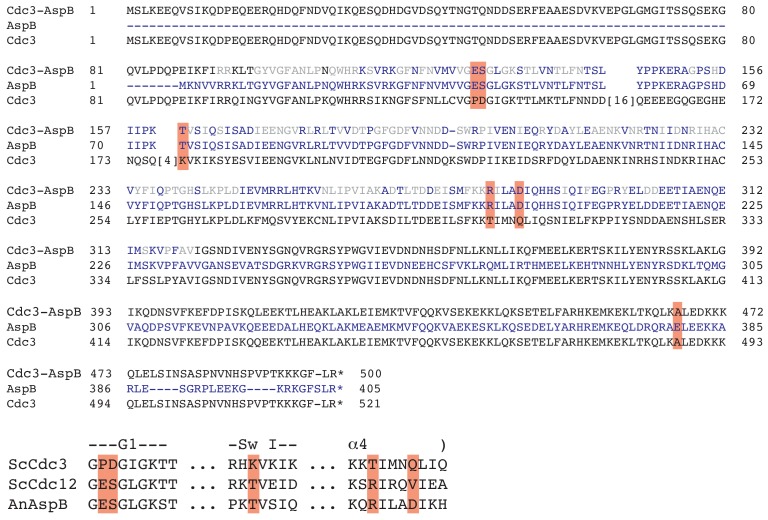
Sequence of the Cdc3-AspB chimeric protein and comparison of key residues between Cdc3, AspB, and Cdc12.Alignments of S. cerevisiae Cdc3 with Aspergillus nidulans AspB and the Cdc3-AspB chimera (above), and with S. cerevisiae Cdc12 and A. nidulans AspB (below). Red highlighting indicates positions that covary with the catalytic Thr in Cdc3 homologs, as in Figure 4—figure supplement 1B.